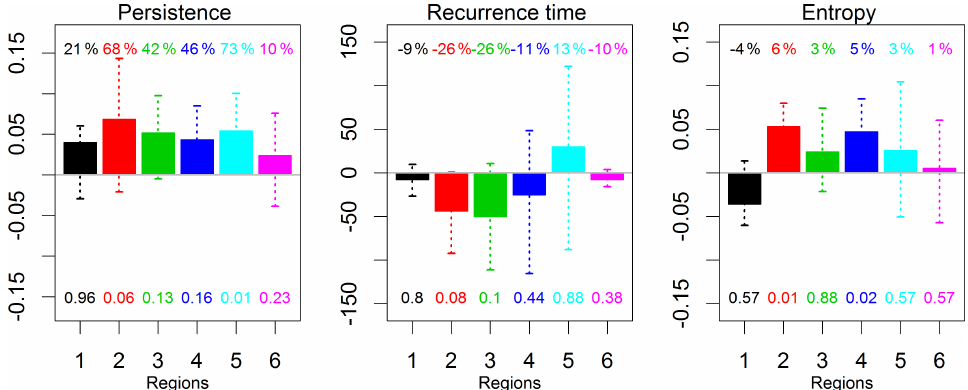
Figure 9. Climate change signal of descriptors for cold and wet extremes in winter (DJF) (Ta < 10th percentile and Pa > 75th percentile). Changes between the time periods 1971–2000 and 2021–2050. Bars show the ensemble mean (of the individual change signals) and whiskers the 75th and 25th quantile, respectively. Percentages above the bars denote the relative change of the ensemble mean, the numbers below the p value. The coloring corresponds to the regions in Fig. 1.